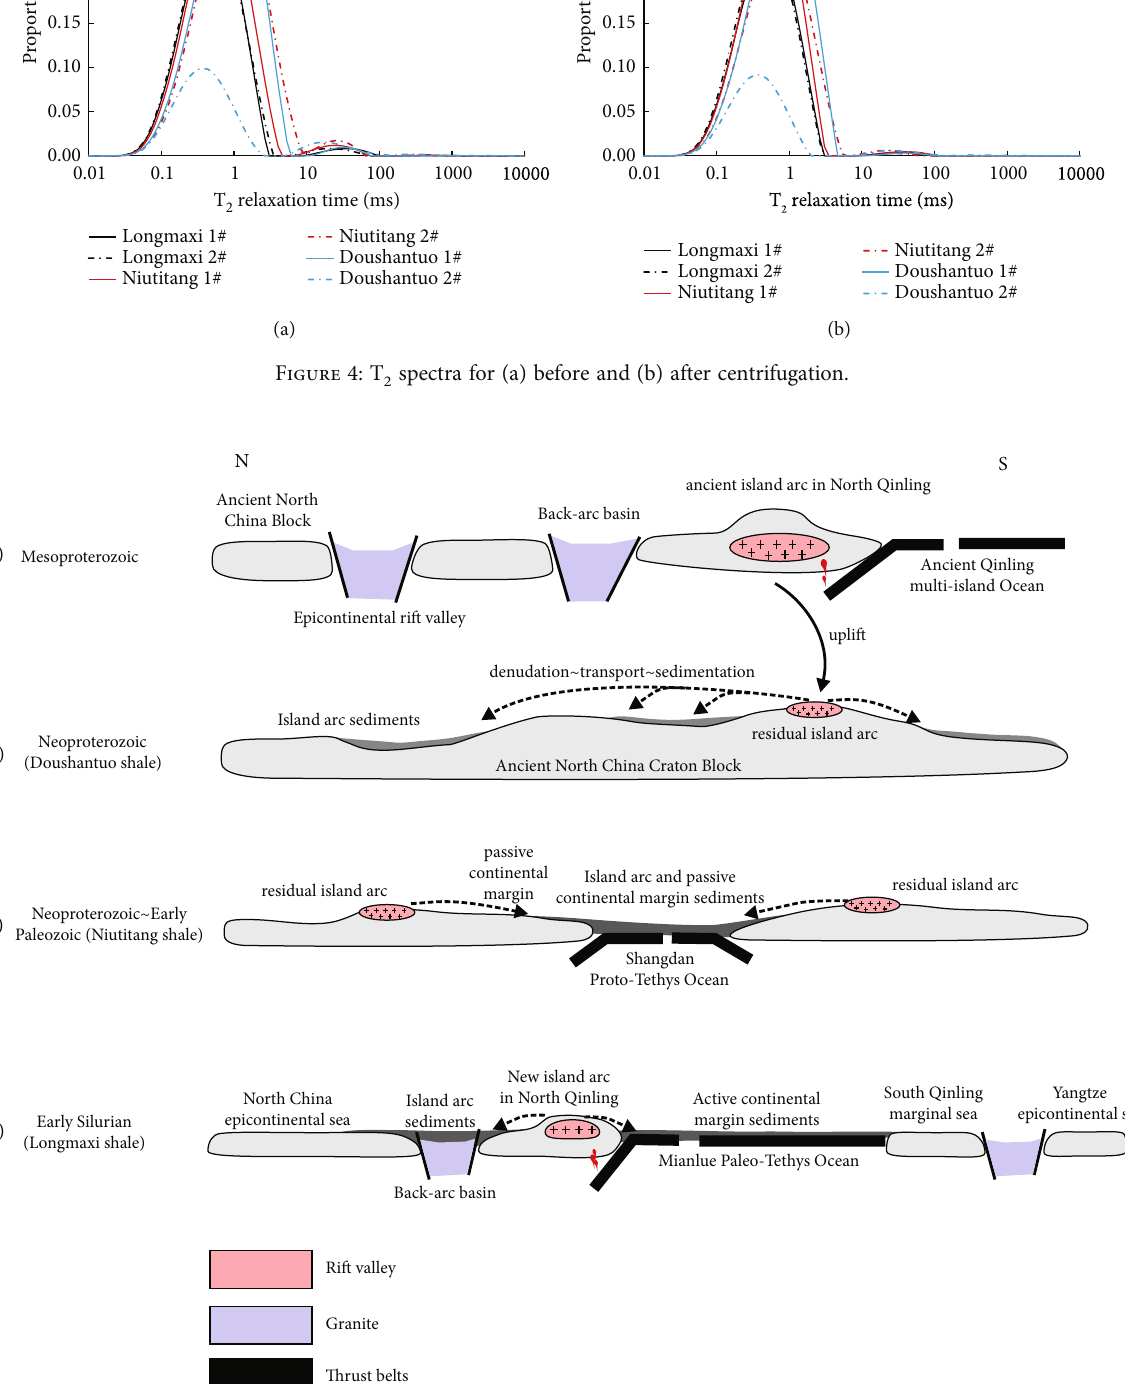
Figure 5: The relationships between the sediment ’ s provenance and tectonic setting of shale. (a) Mesoproterozoic, (b) Neoproterozoic, (c) Neoproterozoic-Early Paleozoic, and (d) Early